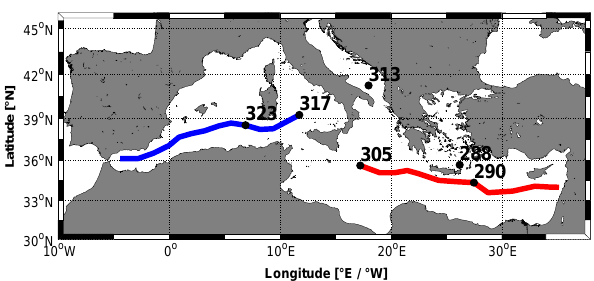
Figure 6. Sections and key stations of the transient tracer analy- sis. The red line shows the EMed section, the blue line the WMed section and the black dots the key stations.